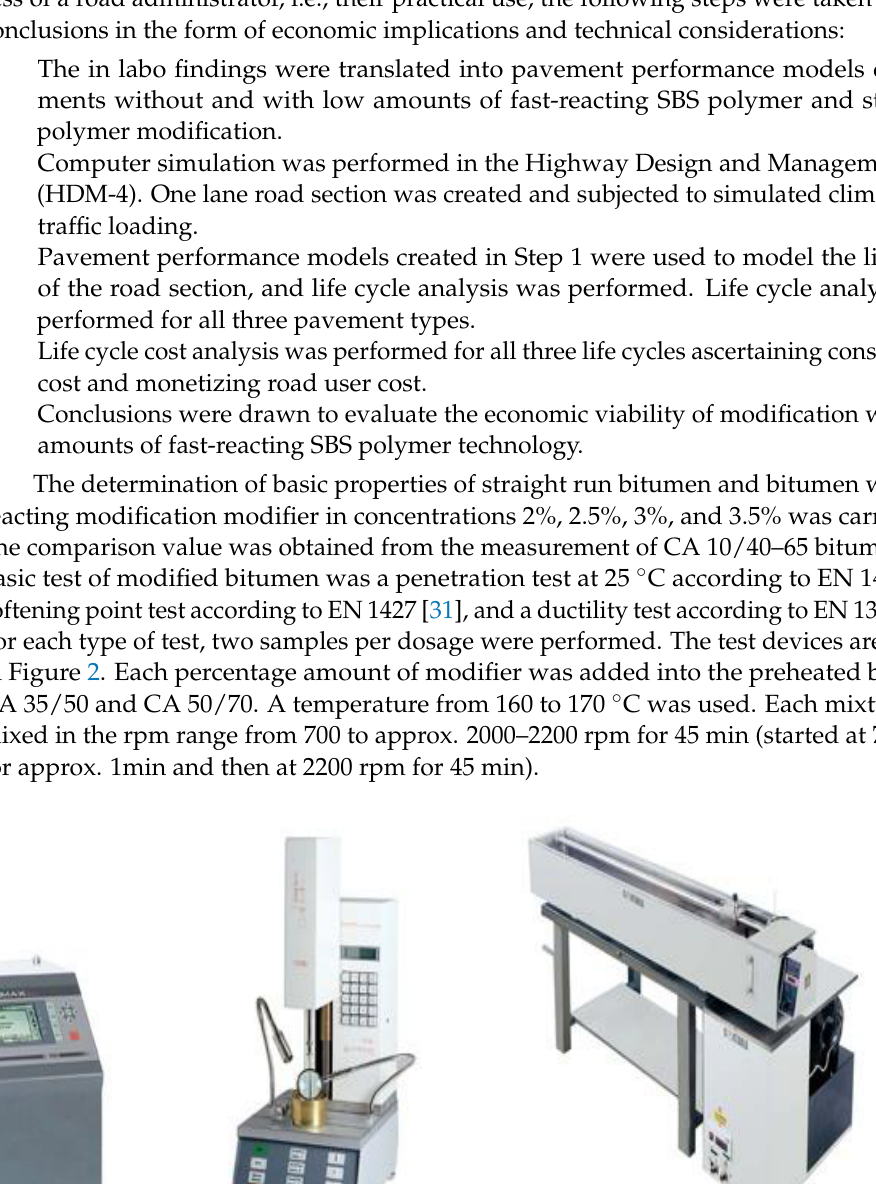
Table 1. Basic properties of bitumen and modifiers. Modifier Concentration (%)